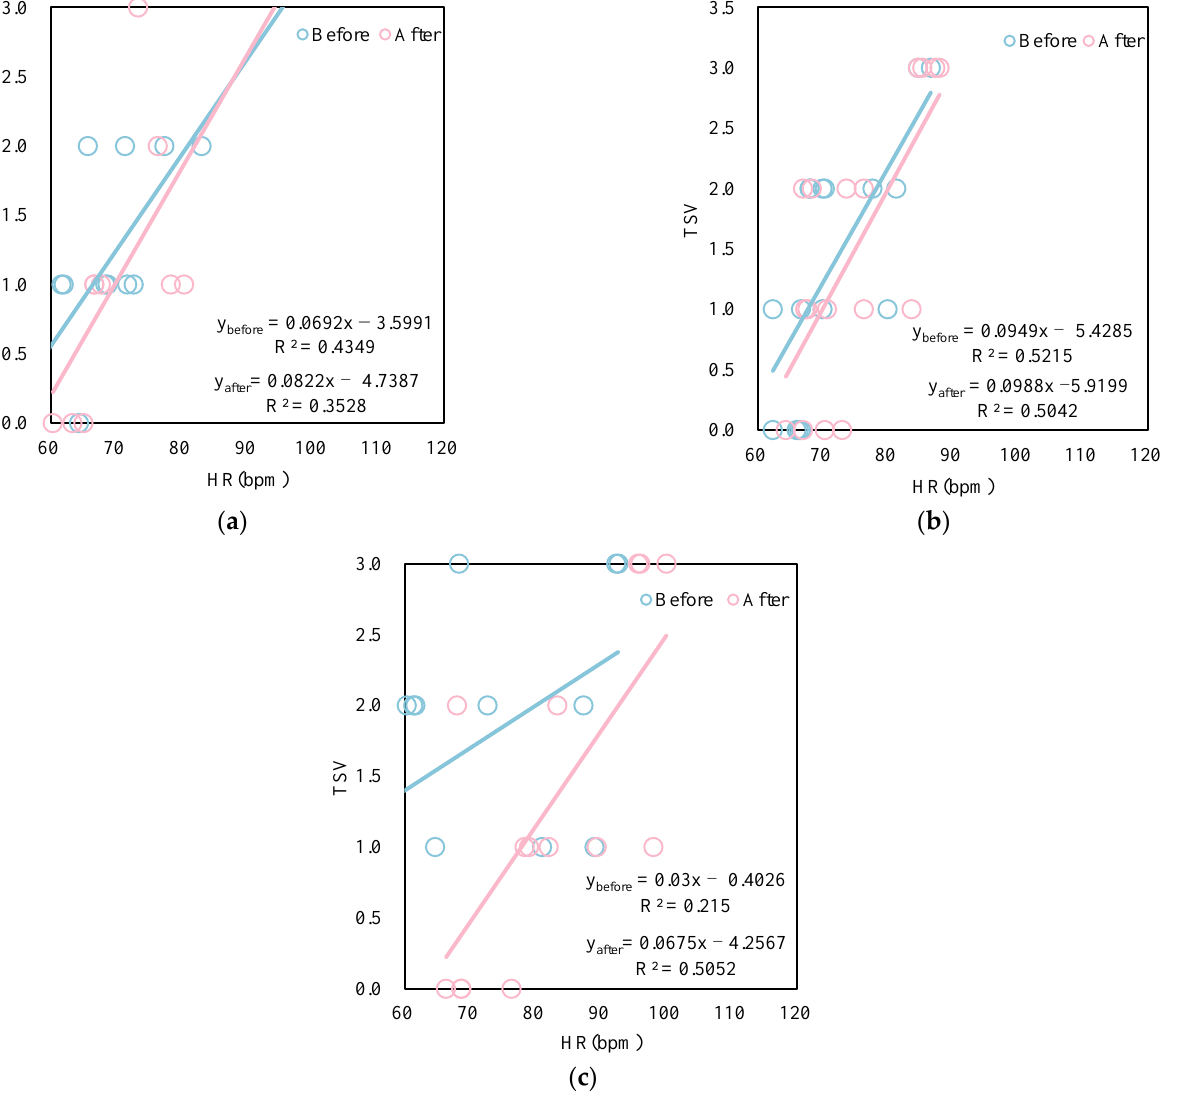
Figure 11. Relationships between HR and MTSV (light ( a ), moderate ( b ), and vigorous ( c ) intensi- ties).